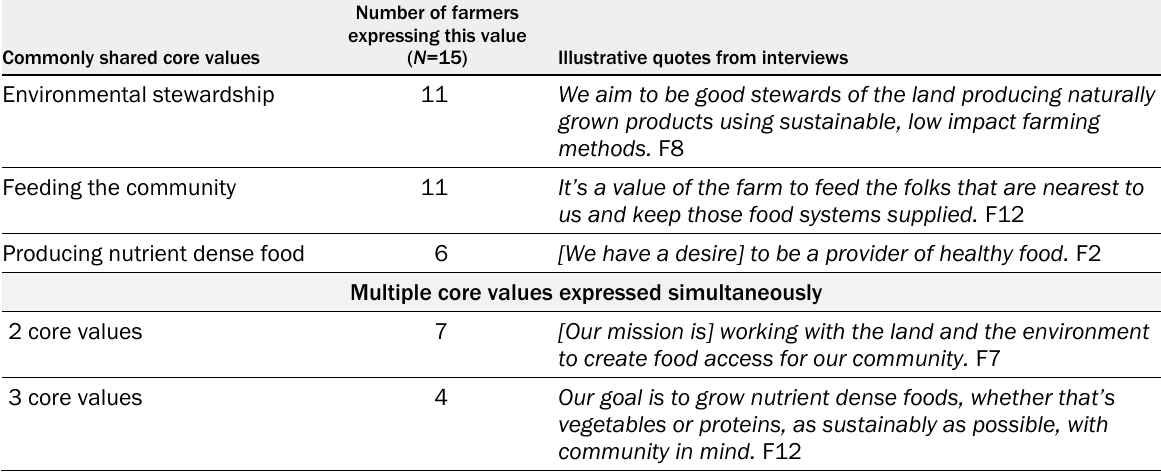
Table 2. Core Values and Illustrative Examples as Expressed by Interviewees Commonly shared core values